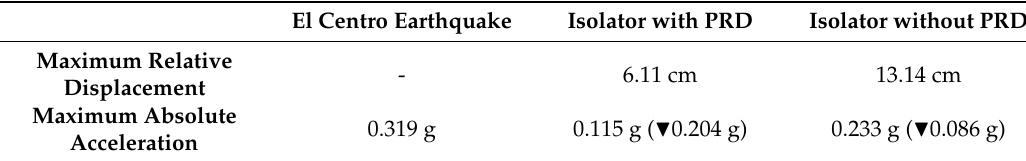
Figure 12. Responses of the system to earthquake excitation in case of k / M = 0 and ς r = 0.3. Table 3. Maximum values of seismic responses.